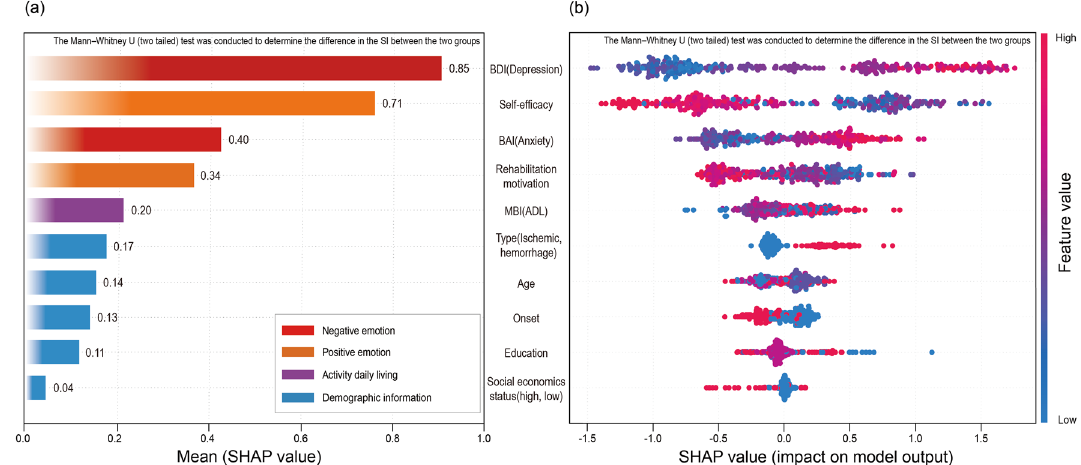
Figure 2. Feature importance based on SHAP values (The red and blue dots indicate that the variables at that point had positive and negative effects on the SI occurrence, respectively): ( a ) Mean absolute SHAP values ( b )